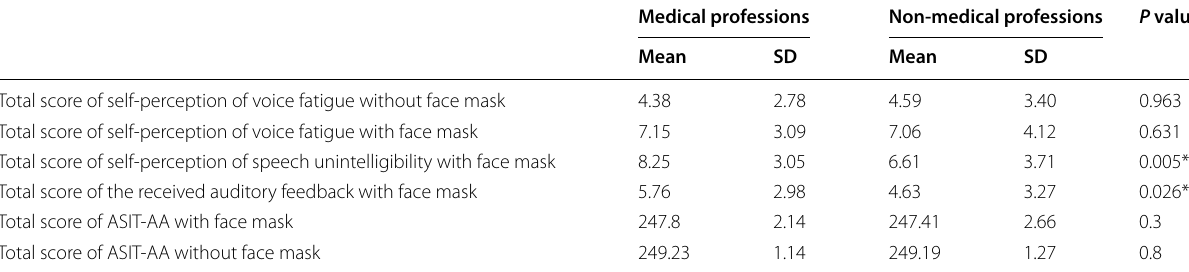
* Significant p value, SD standard deviation, ASIT-AA Arabic Speech Intelligibility Test for Adolescents and Adults